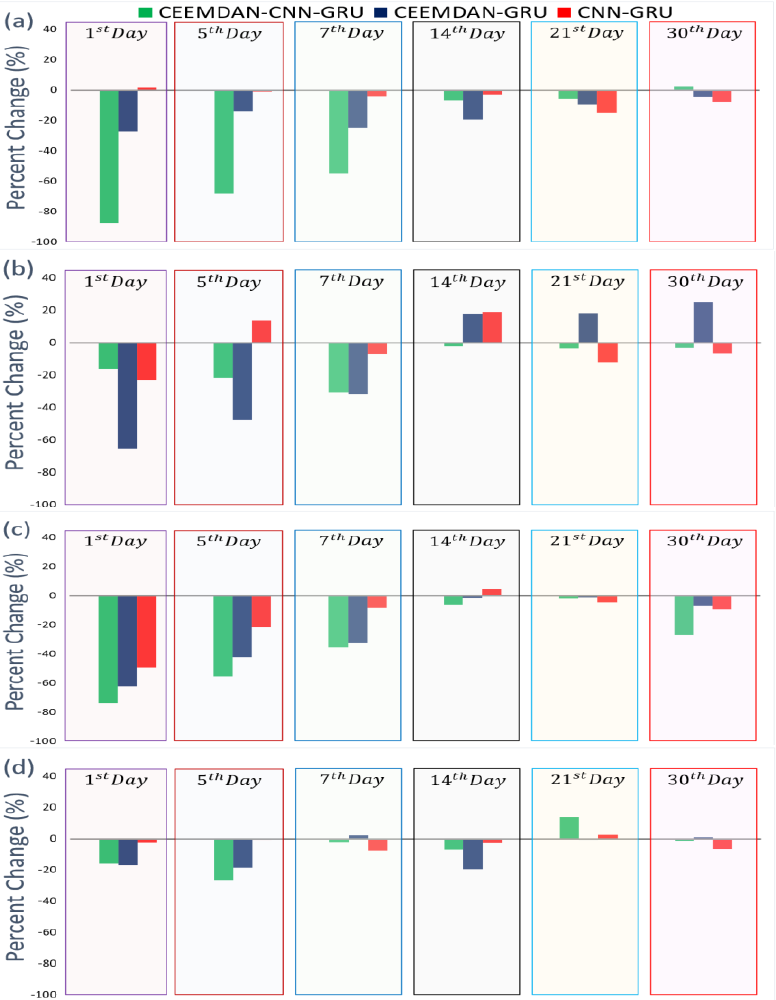
Figure 12. The percentage change in RMAE generated by the objective, and benchmark models using CEEMDAN and CNN methods (as data decomposition and feature extraction methods) adopted in forecasting SSM at four study sites: Murray Darling Basin. ( a ) Menindee, ( b ) Deniliquin, ( c ) Fairfield, ( d ) Gabo Island at different n th ( n = 1, 5, 7, 14, 21, and 30) day ahead forecasting SSM.